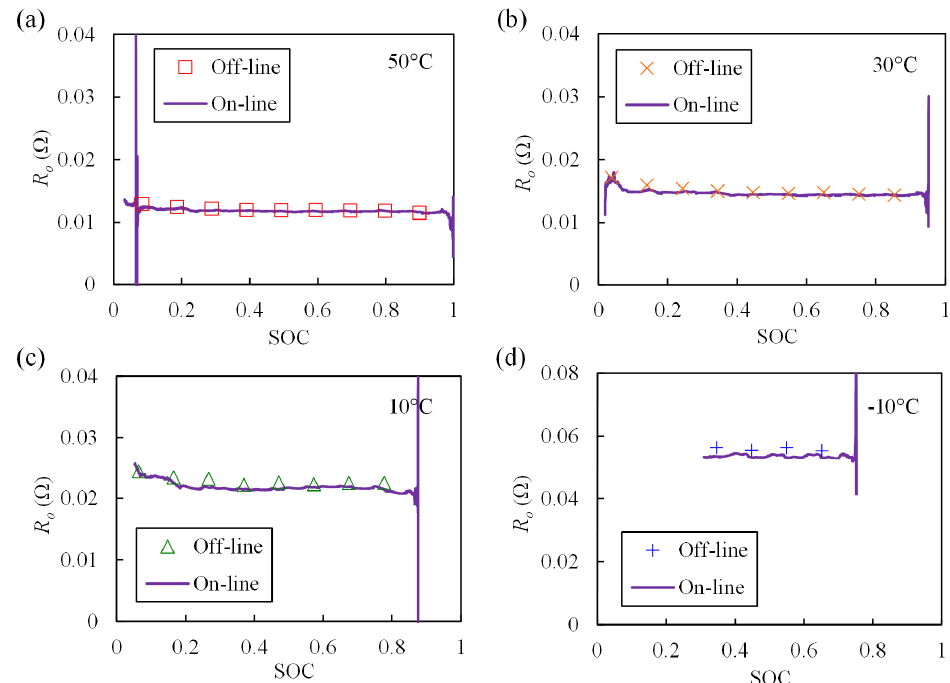
Figure 8. The comparison of the identification and reference values of R o : ( a ) fresh values at 50 °C; ( b ) the values after 100 cycles at 30 °C; ( c ) the values after 200 cycles at 10 °C; ( d ) the values after 300 cycles at − 10 °C.